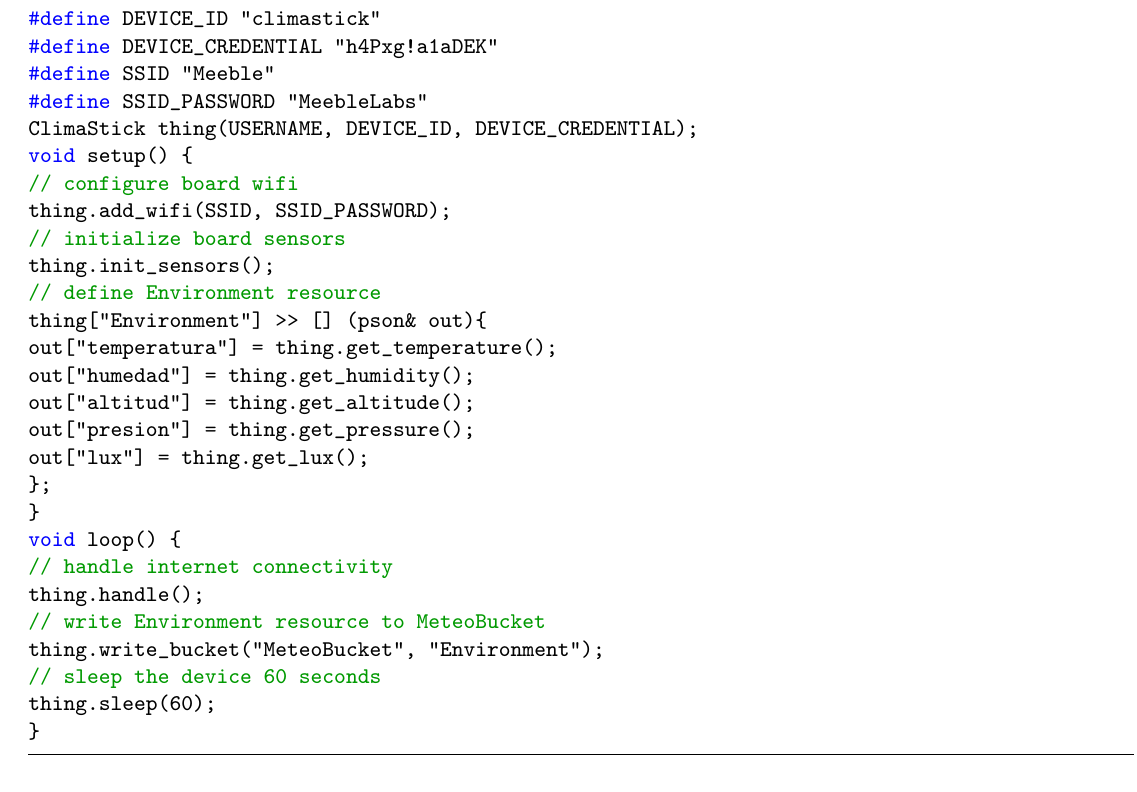
Figure 21. An example of modelig a device in